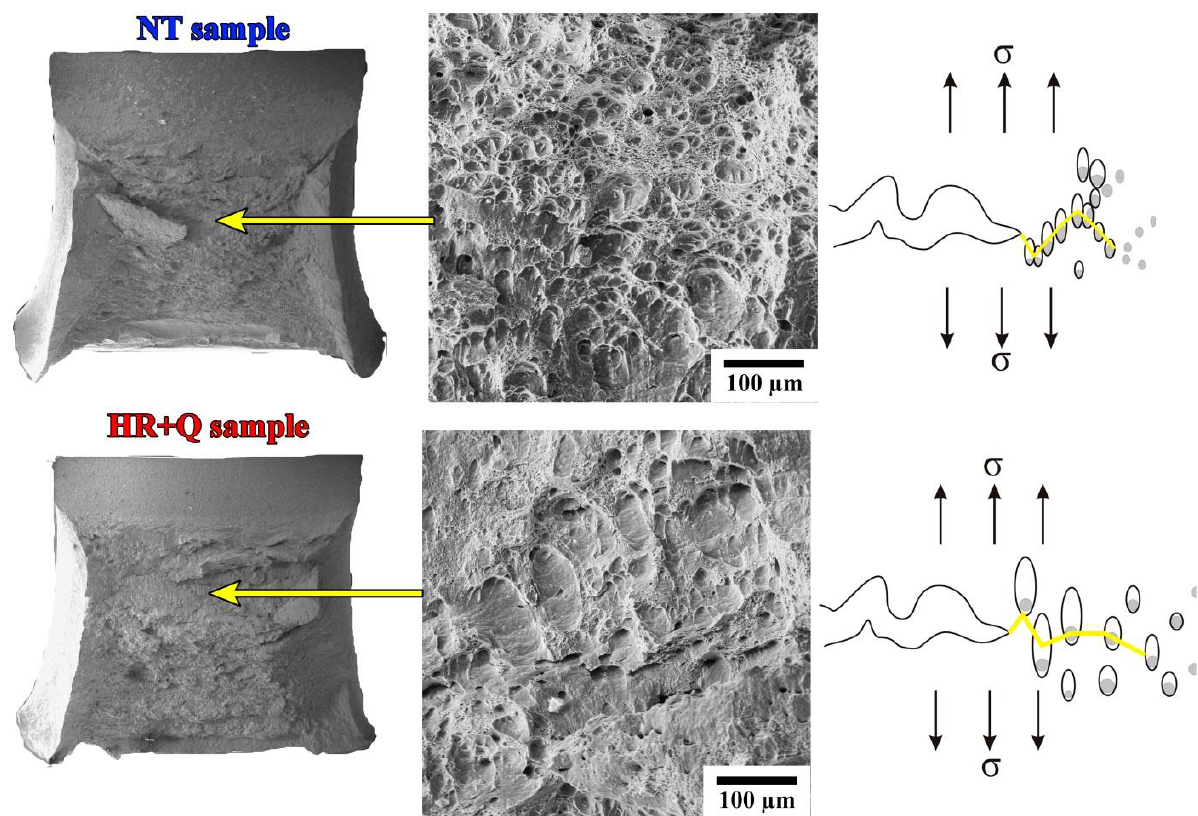
Figure 15. SEM images showing the fracture surface of the NT and HR+Q samples tempered at 780 °C and tested at 150 °C along with schematic illustration of the ductile crack propagation process.